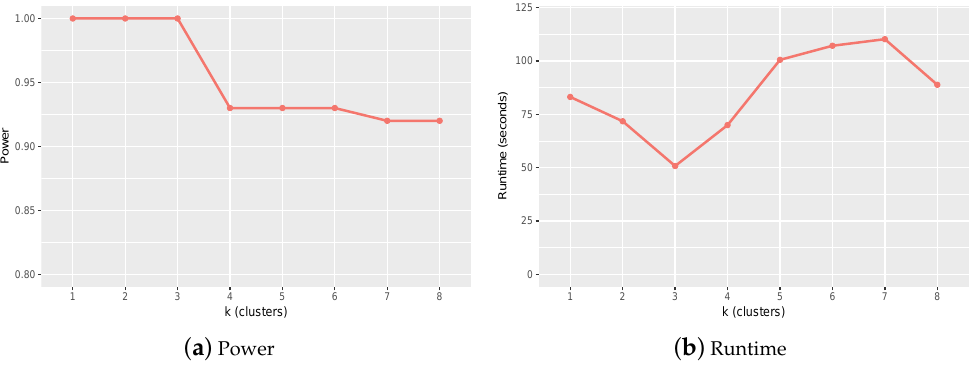
Figure 1. Power and runtime of ClusterMI under different numbers of clusters ( k ) . ( a ) Power of ClusterMI for different k ; ( b ) runtime of ClusterMI for different k .